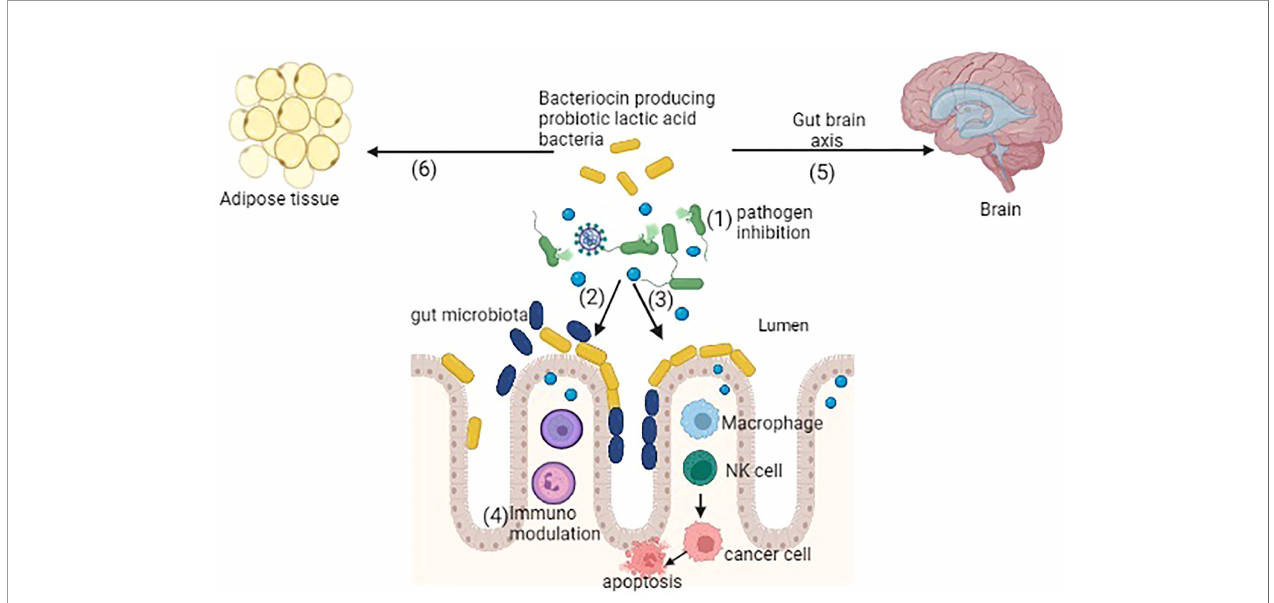
FIGURE 1 | Bacteriocin-producing probiotic lactic acid bacteria showing several potential functions: (1) inhibition of pathogens, (2) colonization of probiotic bacteria by competitive exclusion, (3) activation of macrophages, natural killer (NK) cells further interact with cancer cells causing apoptosis, (4) immunomodulation, (5) gut – brain axis balancing the gut microbiota, (6) antiobesity activity by reducing the adipose tissue (created in